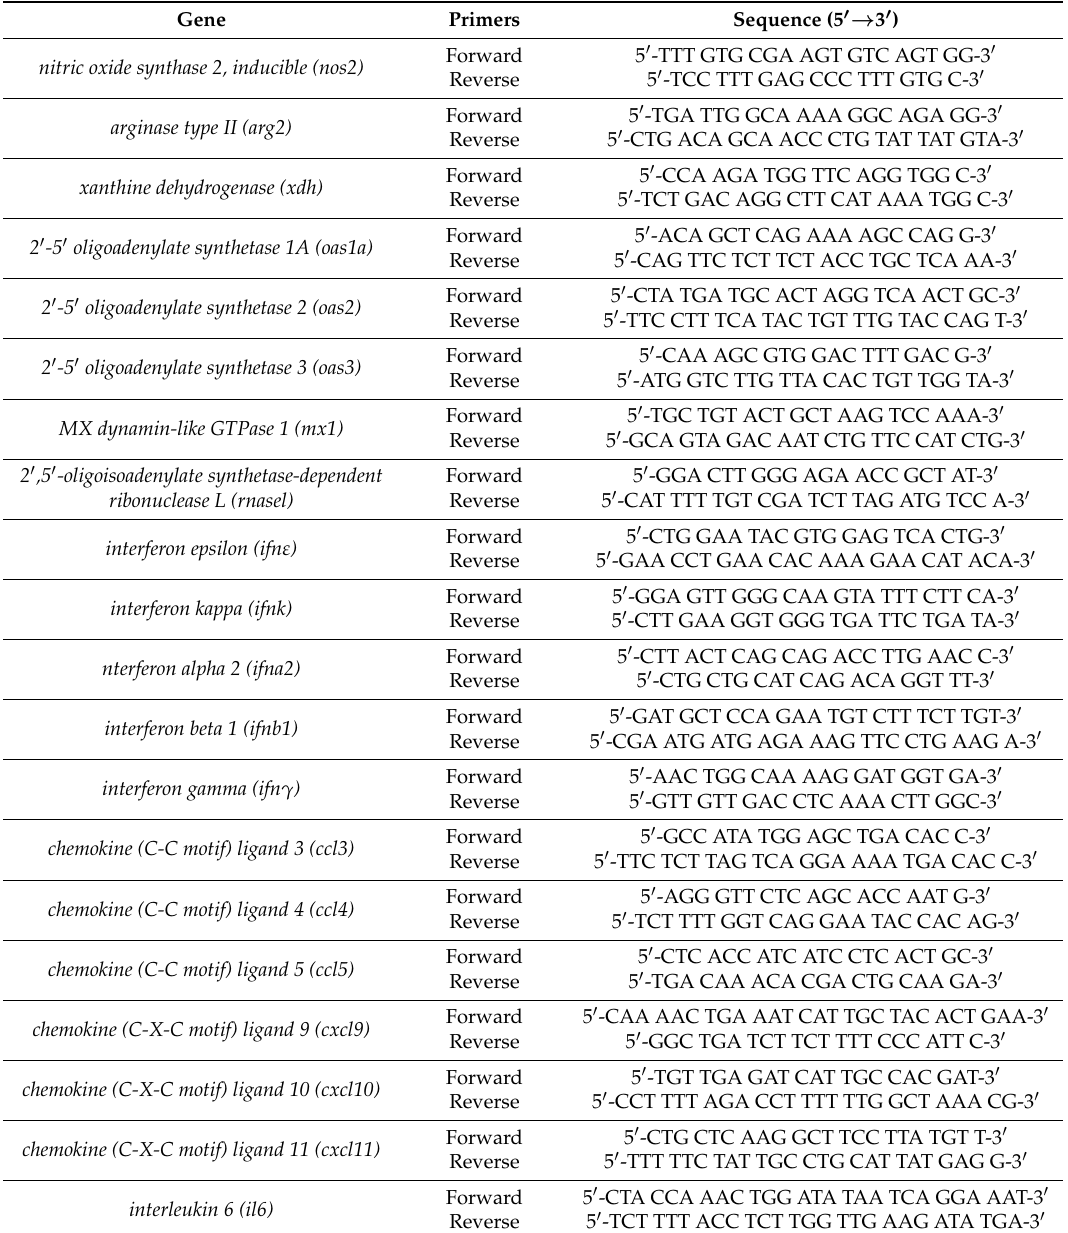
Table 2. Primers used in this